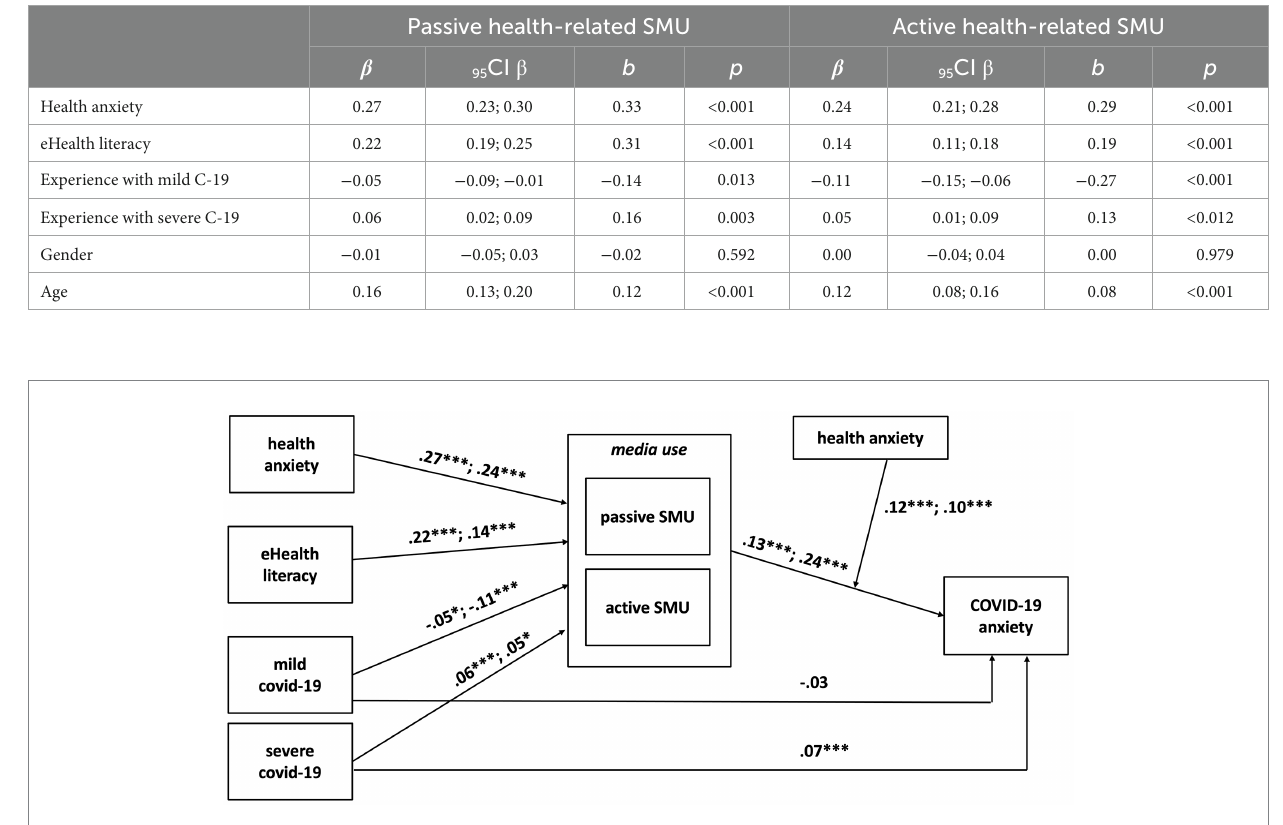
FIGURE 2 The conceptual model, with results. The first number on the description arrows is for passive health-related SMU and the second is for active health- related SMU. Age and gender were included as control variables but are not included for clarity reasons; their effects are reported in Table 2. * p < 0.05, ** p < 0.01, *** p <